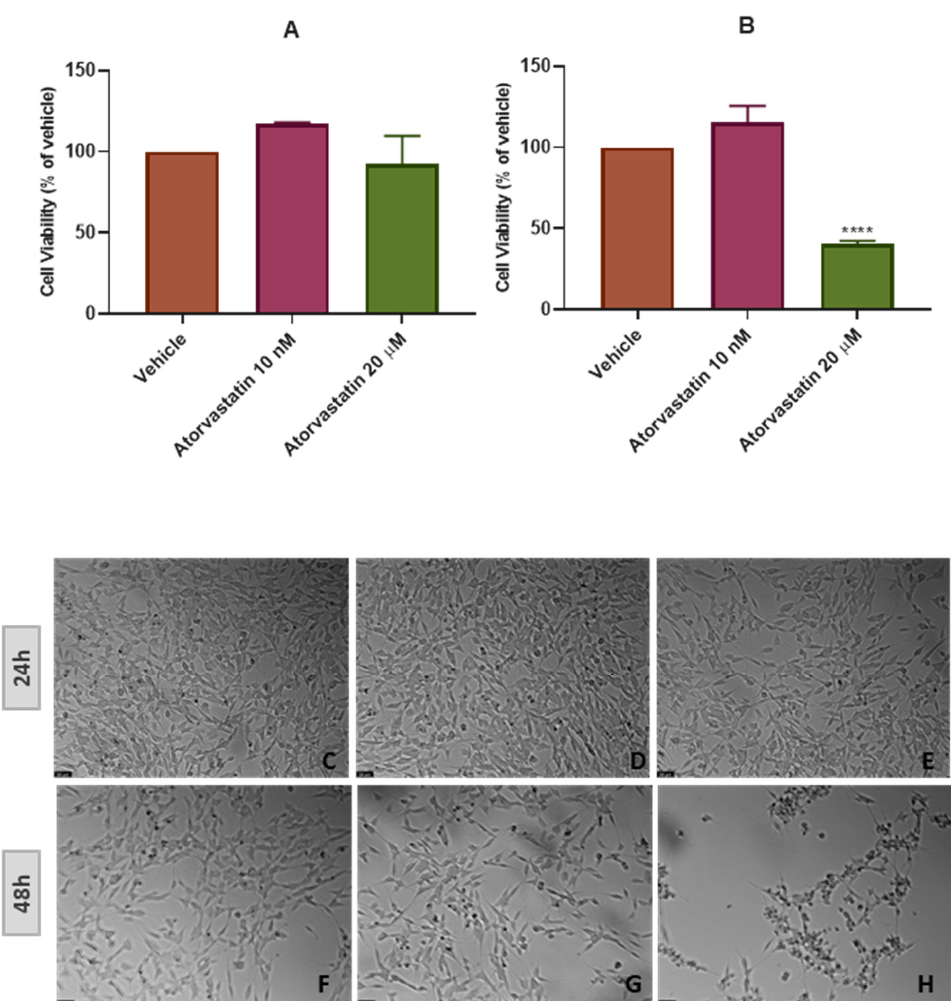
Figure 3. Effect of ( A ) atorvastatin 10 nM and 20 µ M in SH-SY5Y cellular viability for 24 h and ( B ) for 48 h obtained by MTT assay, and representative images (100 × total magnification) of these cells after incubation with ( C , F ) vehicle (DMSO 0.1%), ( D , G ) atorvastatin 10 nM, and ( E , H ) atorvastatin 20 µ M, after 24 h and 48 h. Cell viability results are expressed as the percentage of the vehicle (100%). Statistical significance at **** p < 0.0001 vs. vehicle.